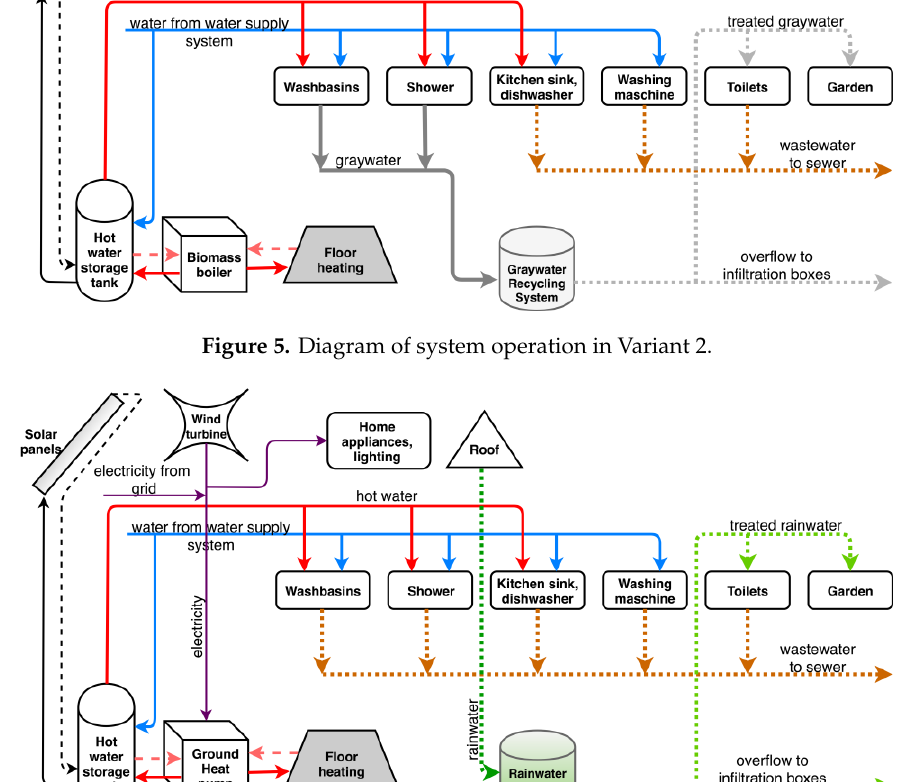
Figure 6. Diagram of system operation in Variant 3.